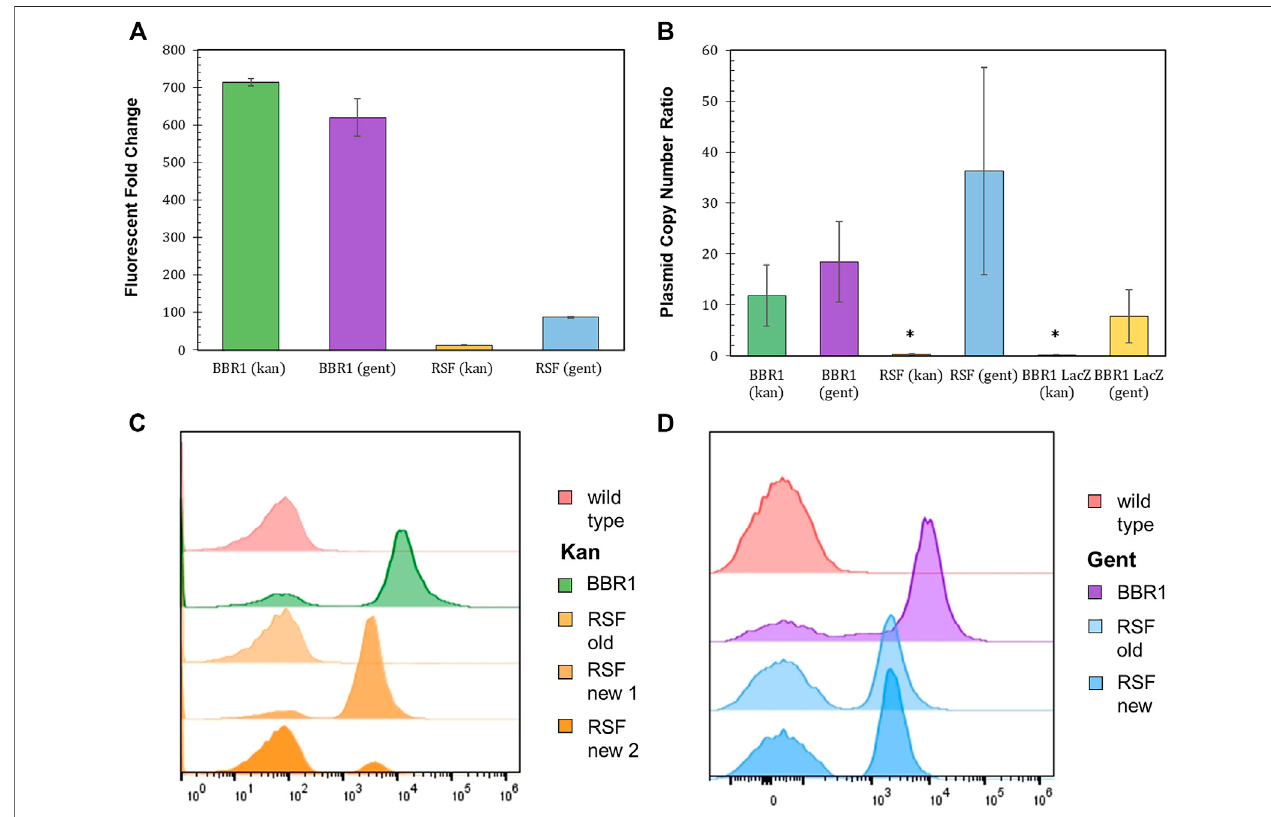
FIGURE4 | Origin of replication characterization with different selection markers and reporters. (A) Fluorescent fold change average of R. palustris BBR1- kan-mRFP, BBR1-gent-mRFP, RSF1010-kan-mRFP,and RSF1010-gent-mRFP strains grown in triplicate. The antibioticconcentrations added to the media of the mutant strains but notwild type R. palustris were 300 μ g/mlkanamycin sulfate and 300 μ g/mlgentamicin sulfaterespectively (Materials and Methods). Error bars represent the population standard deviation. (B) Average plasmid copy number for the R. palustris BBR1-kan-mRFP, BBR1-gent-mRFP, RSF1010- kan-mRFP, RSF1010-gent-mRFP, BBR1-kan LacZ, and BBR1-gent-LacZ strains grown in at least duplicate. The antibiotic concentrations added to the media of the mutant strains were 300 μ g/ml kanamycin sulfate and 300 μ g/ml gentamicin sulfate respectively. Copies of the kanamycin and gentamycin selection marker gene were compared to the single copy dxs gene in the chromosome by qPCR and an external standard curve. * indicates a statistically signi fi cant plasmid copy number of less than 1, 0.34-fold for the RSF1010-kan-mRFP strain and 0.16 for the BBR1-lan-LacZ strain (Materials and Methods). Error bars representthepopulation standard deviation. (C) Representative fl owcytometry resultsofmRFP fl uorescencefrom R.palustris wild type, BBR1-kan-mRFP,and RSF1010-kan-mRFP strains grown in triplicate. The old RSF1010-kan cultures had been streaked from frozen stock 2 weeks earlier. The new RSF1010-kan cultures were single colonies from a new transformation. The growth procedure, media, and antibiotics are the same as for the fl uorescent fold change test in Figure 4A (Materials and Methods). (D) Representative fl ow cytometry results of mRFP fl uorescence from R. palustris wild type, BBR1-gent-mRFP, and RSF1010-gent-mRFP strains grown in triplicate. The old RSF1010-gent cultures had been streaked from frozen stock 2 weeks earlier. The new RSF1010-gent cultures were single colonies from a new transformation. The growth procedure, media, and antibiotics are the same as for the fl uorescent fold change test in Figure 4A (Materials and